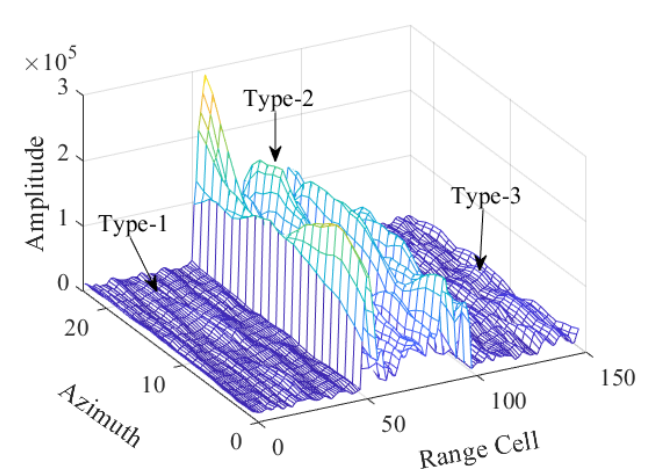
Figure 9. The three types of clutter splicing scene after pulse compression. In the schematic diagram, each clutter occupies 50 range cells.